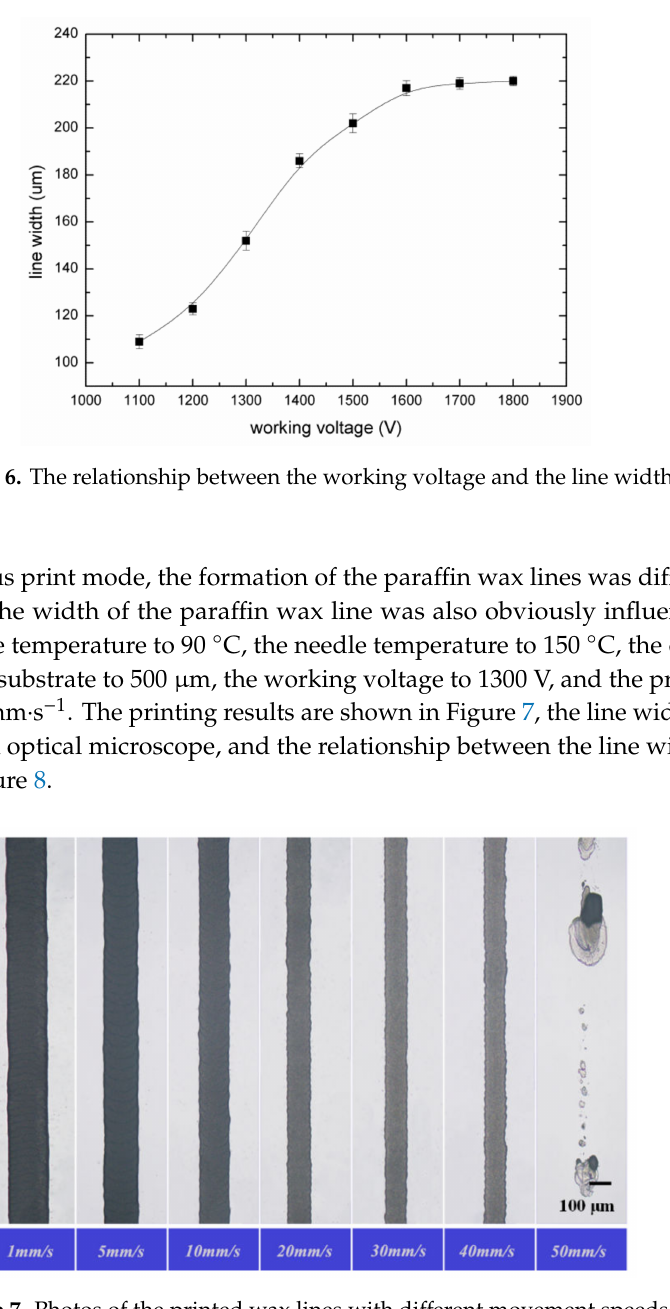
Figure 7. Photos of the printed wax lines with di ff erent movement